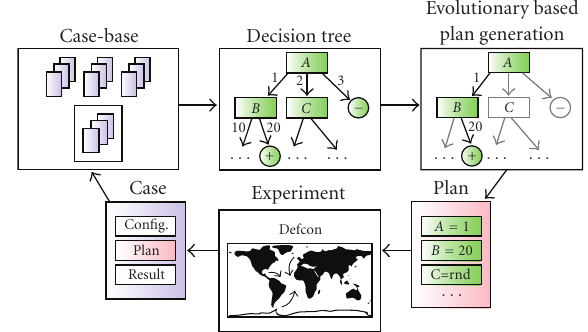
Figure 1: Screenshot of DEFCON.